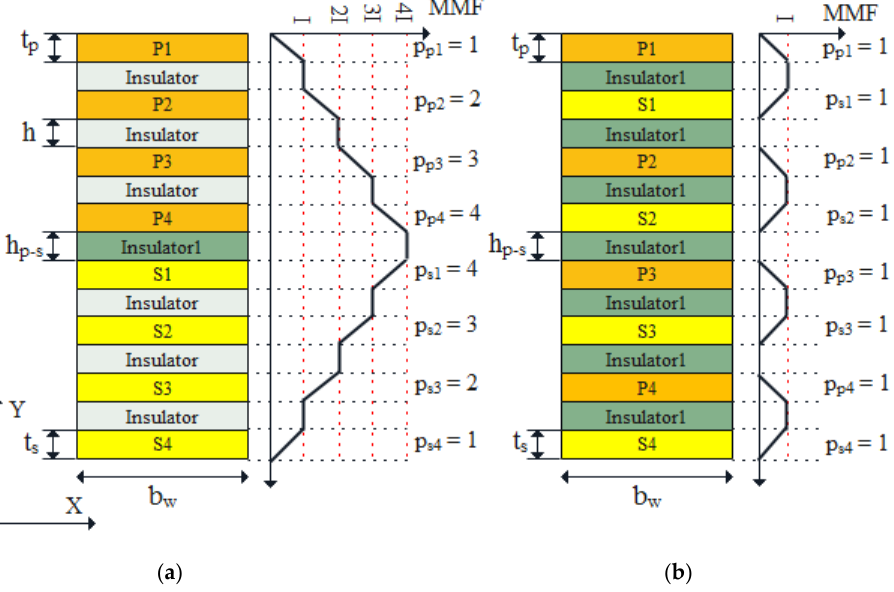
Figure 6. MFF distributions ( a ) Non-interleaving arrangements, ( b ) Interleaving arrangements.